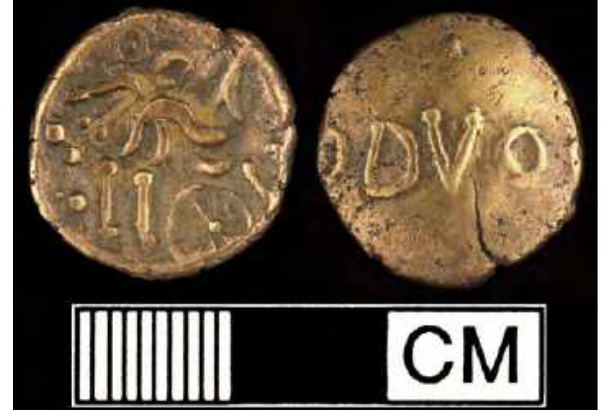
Fig 2.35 Iron Age stator from Tiverton, Cheshire